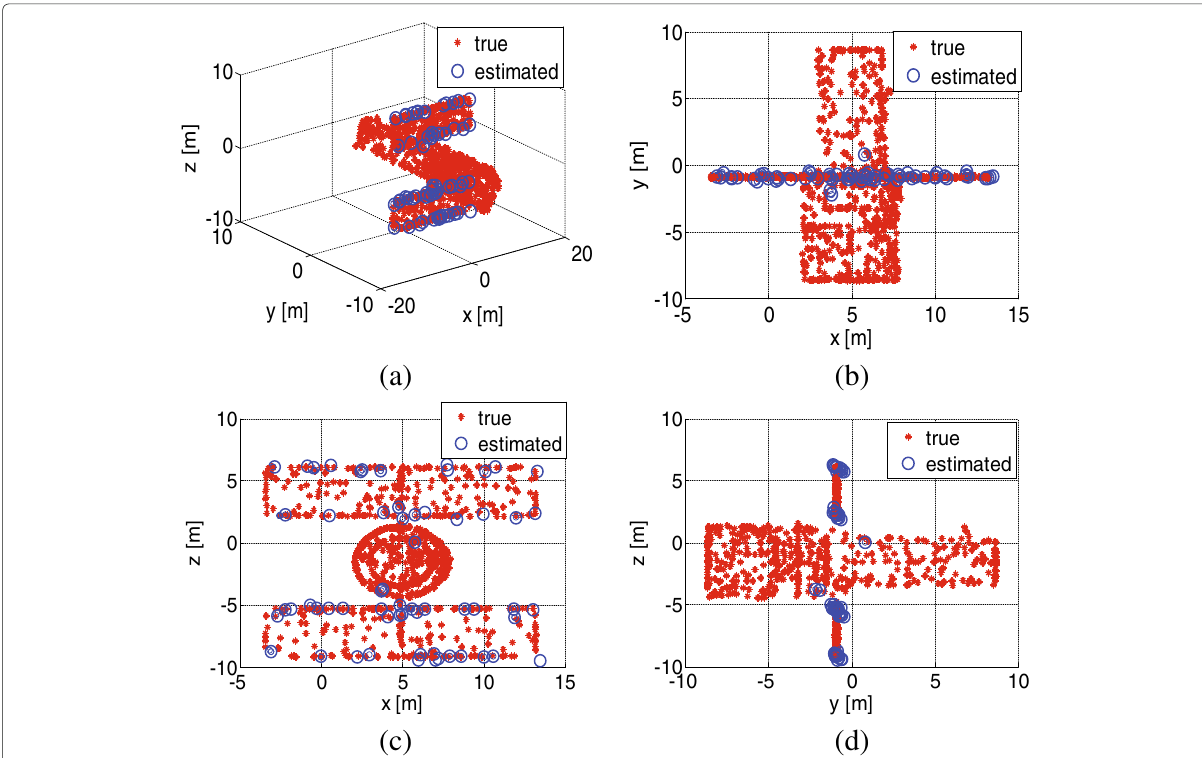
Fig. 10 3D reconstruction result using HST model. a Estimated positions of scattering centers along with the true positions. b Top views. c Front views. d Side